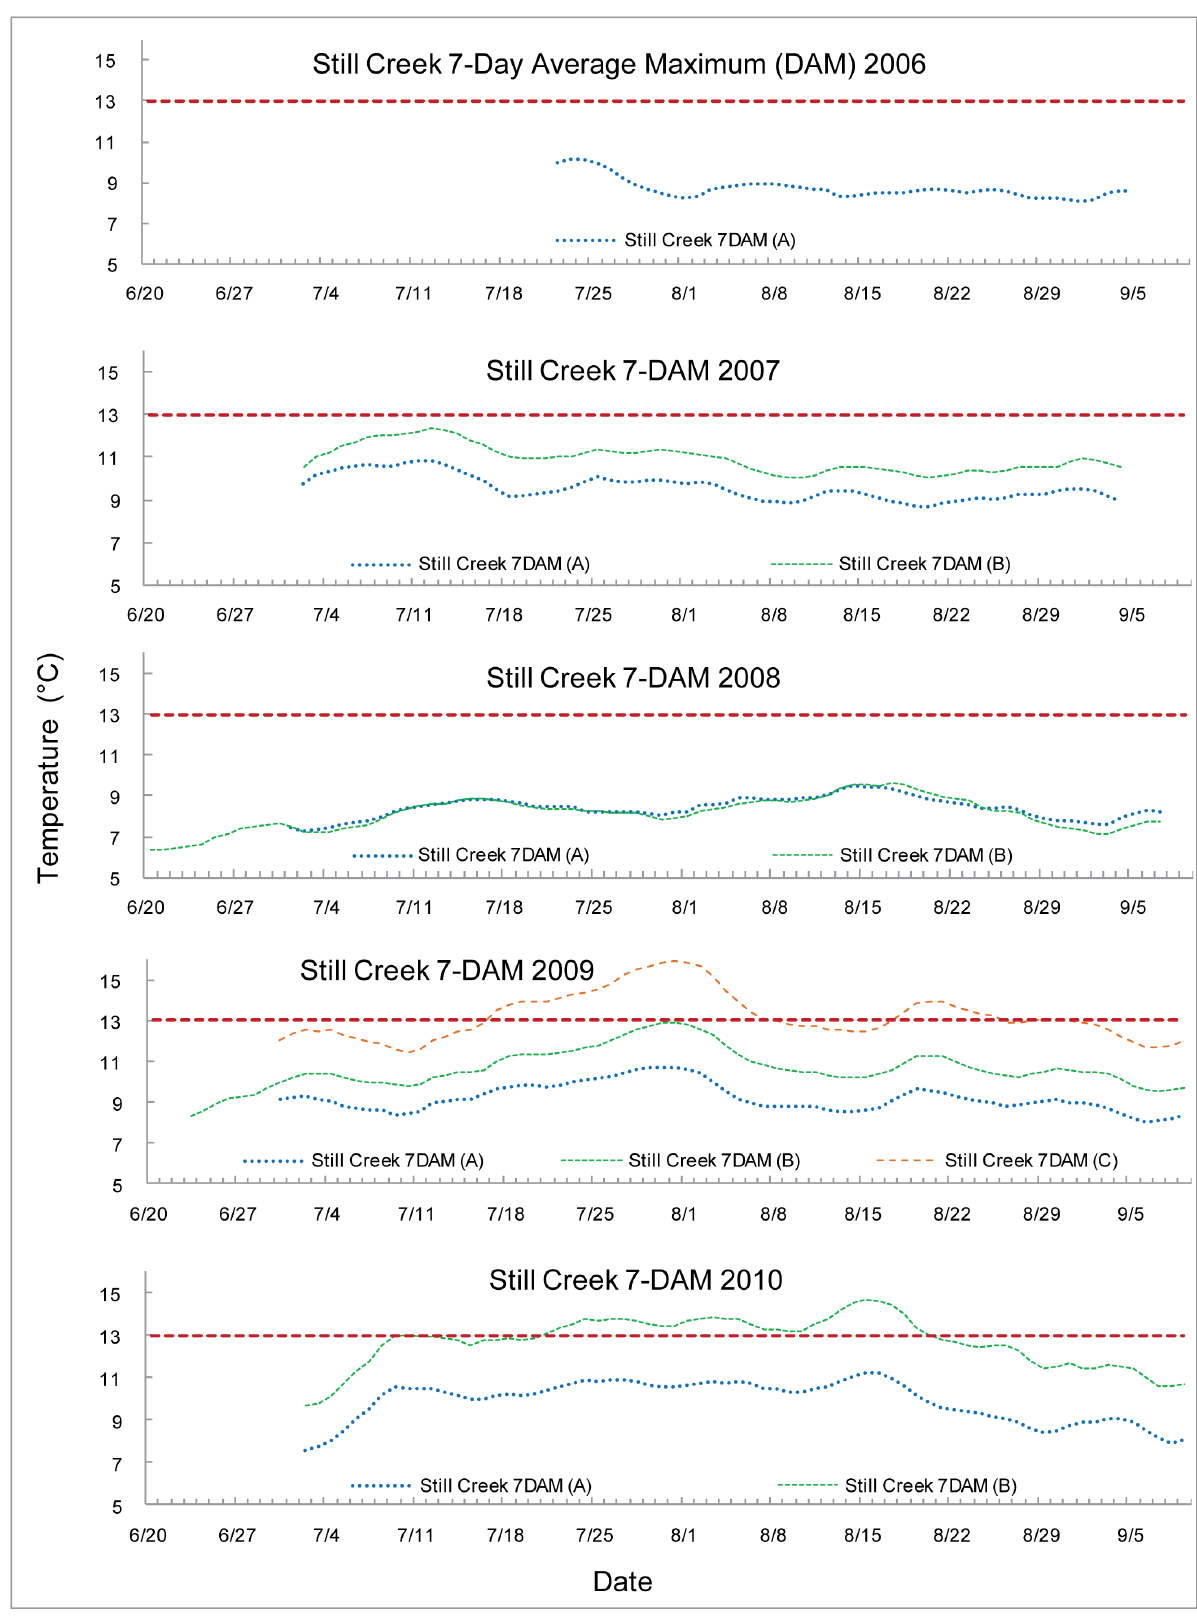
Figure 5. 7-Day average maximum (7-DAM) temperatures of Still Creek.